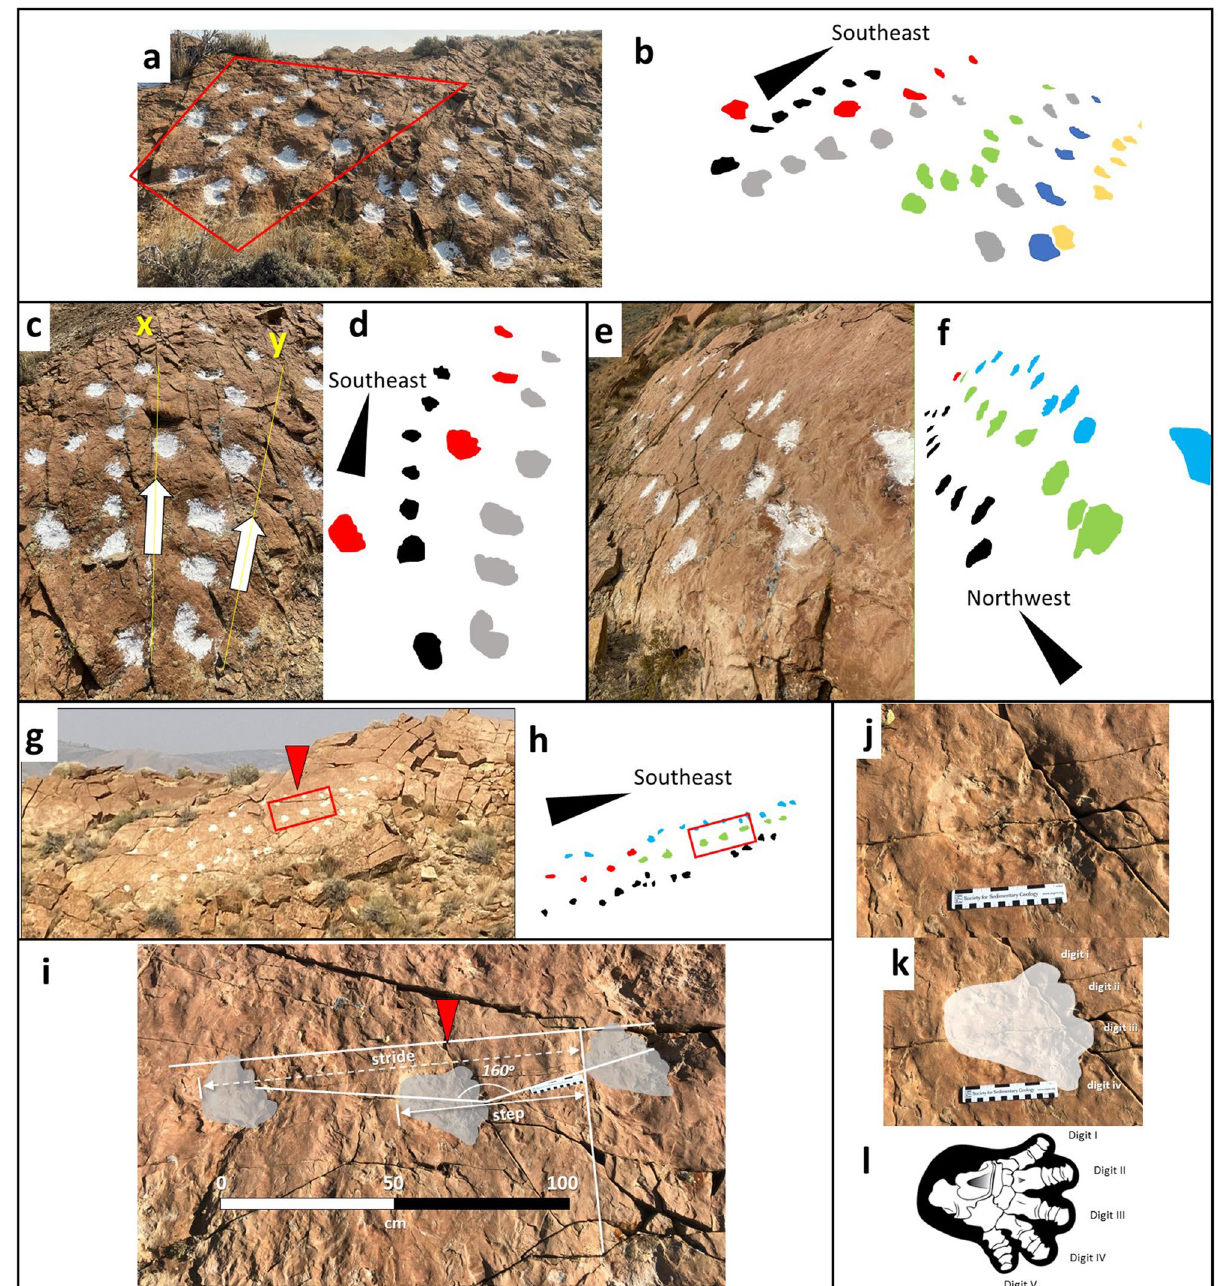
Figure 2. Representative surface expression of trackways. ( a ) Photograph of heavily trampled surface of the uppermost tracksite at the southern end of the outcrop; ( b ) Interpretation of individual trackways; ( c ) Photograph of section of tracksite outlined by polygon in a . Tracks to the left of line X are from a smaller individual. Tracks to left of line Y are from a larger individual; ( d ) Interpretation of individual tracks color coded as in b ; ( e ) Photograph of northern expression of the uppermost trackway; ( f ) Interpretation of individual tracks depicted in e ; ( g ) Photograph of surface of outcrop with four trackways highlighted by baking flour; ( h ) Interpretation of trackways in h ; ( i ) Photograph of representative series of three consecutive tracks in a narrow-gauge trackway from area highlighted by rectangle in g and h showing step, stride, and pace angulation of 160°; ( j ) Photograph of middle track noted by arrow in g – i ; ( k ) Interpretive outline of J with digits labelled; ( l ) Illustration of skeletal elements of Coryphodon radians pes (modified from original 18 ) for comparison with j and k . Drawings made by A F-J W in Adobe Illustrator 2021 (version 25.2.1, https:// www. adobe. com/ produ cts/ illus trator. html). Photographs by A F-J W and compiled in Microsoft PowerPoint (version 16.0.13801.20266, https:// www. micro soft. com/ en- us/ micro soft- 365/ power